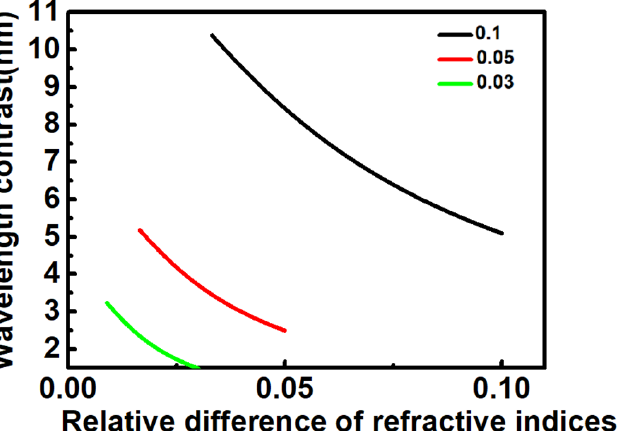
Figure 2. The relationships between the wavelength range contrast ( Δ λ contrast ) and relative differ- ence of refractive indices ( Δ n s-r